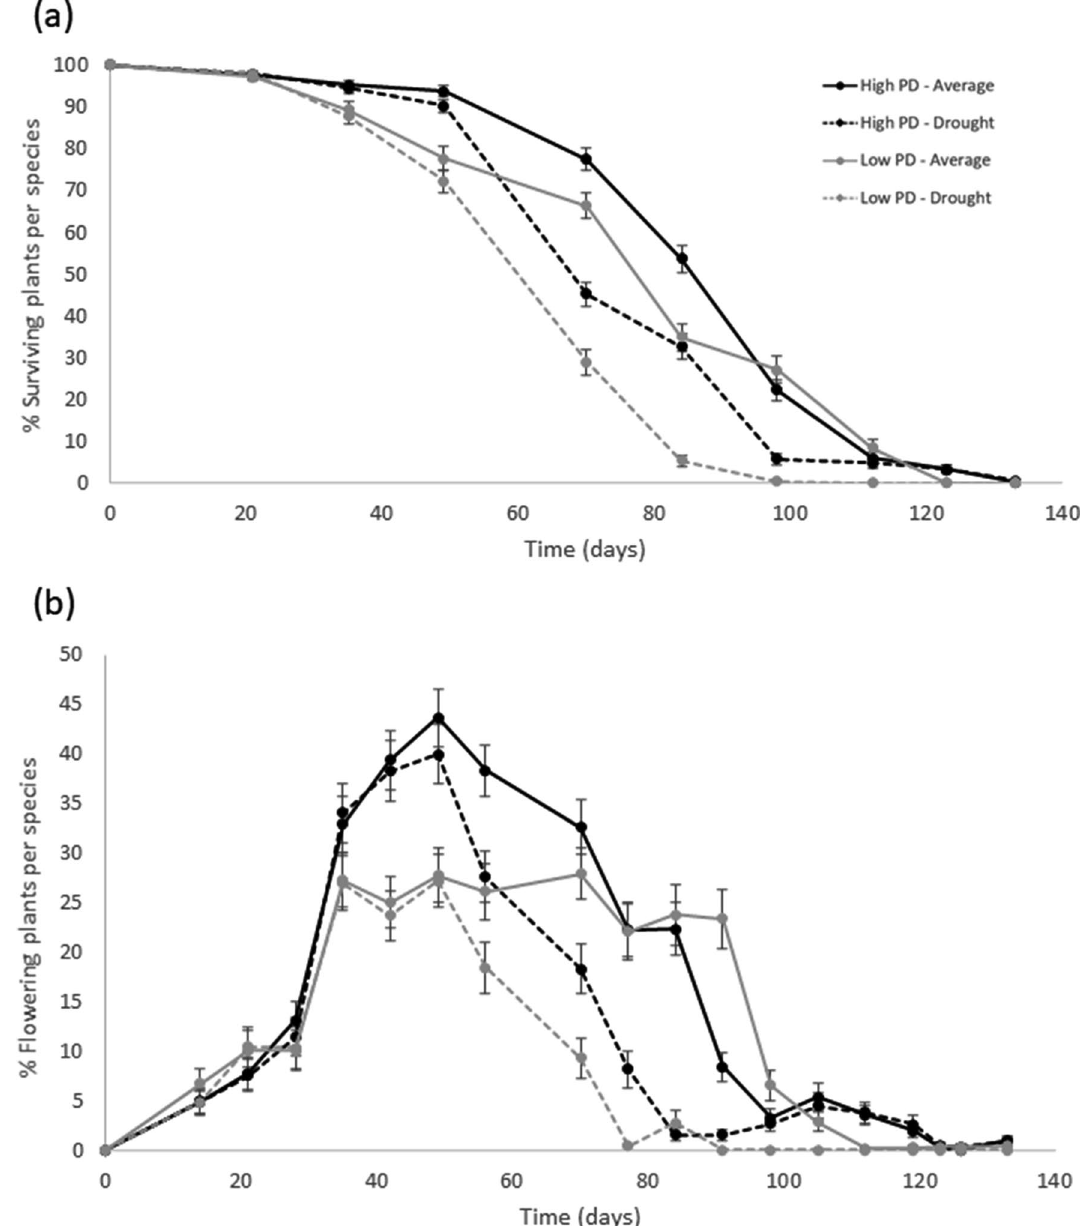
Figure 3. ( a ) Percent of surviving plants and ( b ) percent of flowering plants per species and per pot on each sampling date (see Table 1). Black lines represent high phylogenetic diversity (PD) scenarios and grey lines denote low phylogenetic diversity scenarios. Solid lines represent the average precipitation treatments based on natural precipitation for 30 years, and spotted lines denote drought treatments (33% of the average precipitation). Vertical bars represent the standard